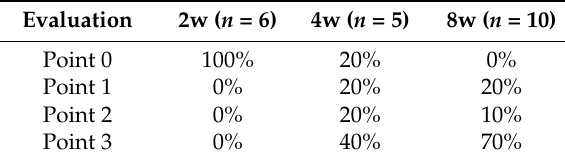
Table 1. Changes in the distribution ratio of the recovery point criteria of vocal-fold movement in the HY